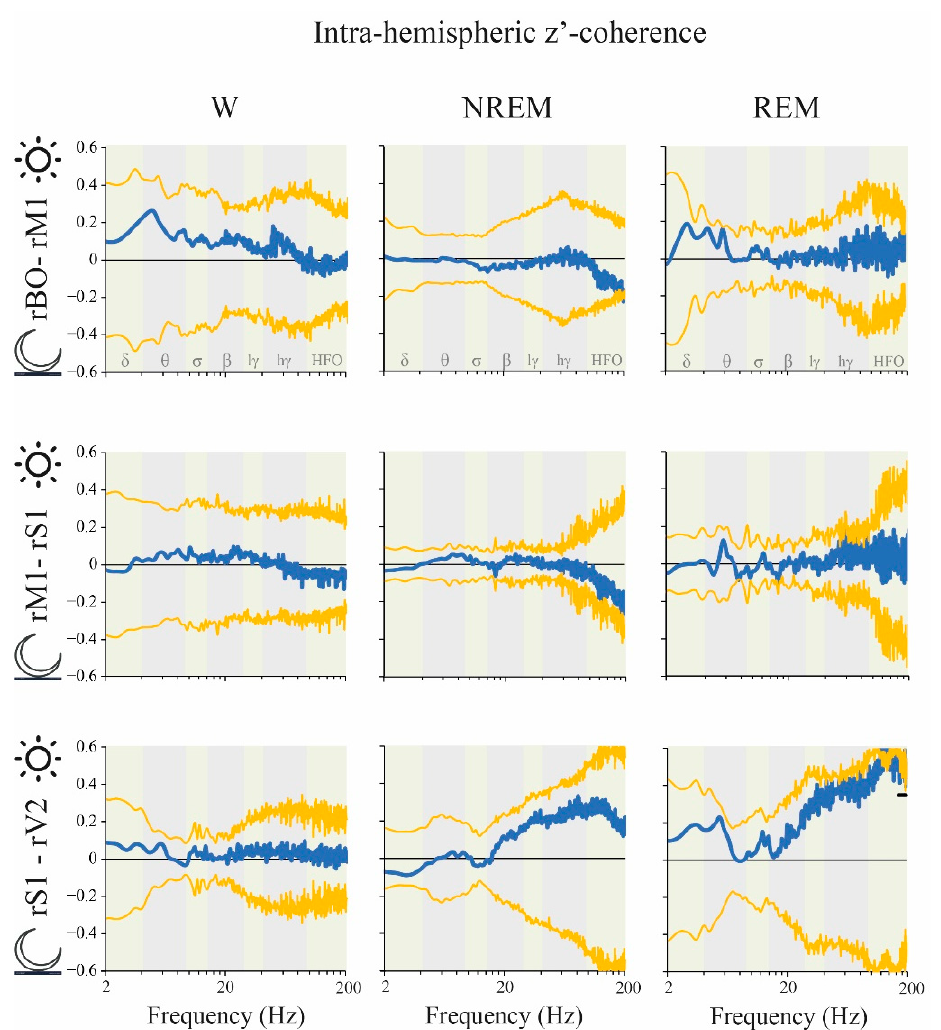
Figure 9. Intra-hemispheric z’-coherence: light vs. dark phases di ff erences. The blue traces indicate the mean z’-coherence di ff erence between light and dark phases. The yellow lines represent the standard deviation of the mean with respect to zero. The statistical evaluation was performed by the two-tailed paired t -test with Bonferroni correction for multiple comparisons; no significant di ff erences were observed ( n = 11). We also performed a data-driven approach comparing empirical clusters of frequencies; black lines represent statistical di ff erences in cluster of frequencies, p < 0.05. During REM sleep, intra-hemispheric S1-V2 z’-coherence was higher during the light phase for the cluster 173–200 Hz ( p = 0.005). OB, olfactory bulb; M1, primary motor cortex; S1, primary somato-sensory cortex; V2, secondary visual cortex; r, right; l γ , low gamma or LG; h γ , high gamma or HG; HFO, high frequency